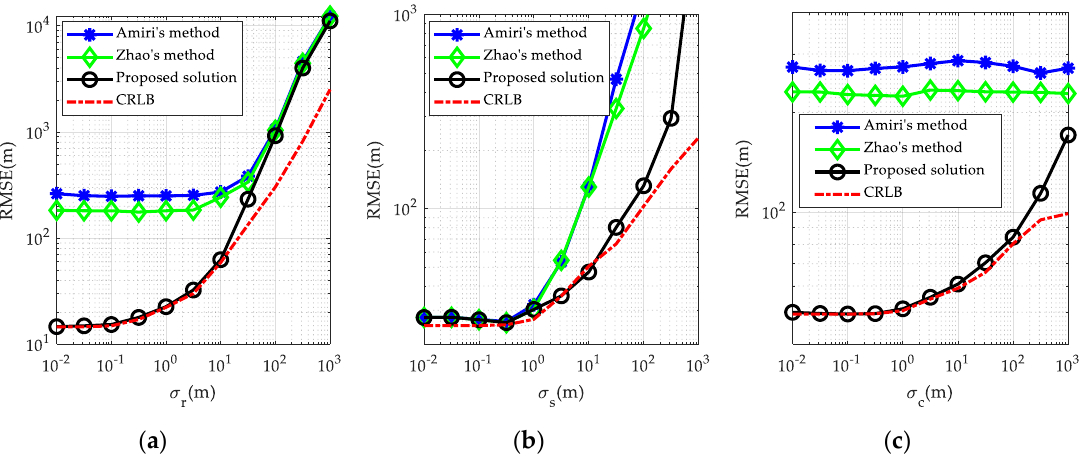
Figure 6. Comparison of the RMSEs among di ff erent localization methods in the near-field case: ( a ) with di ff erent BR measurement noise level σ r and σ s = 20 m, σ c = 10 m; ( b ) with di ff erent transmitter / receiver position error level σ s and σ r = 10 m, σ c = 10 m; ( c ) with di ff erent calibration target position error level σ c and σ r = 10 m, σ s = 20 m.